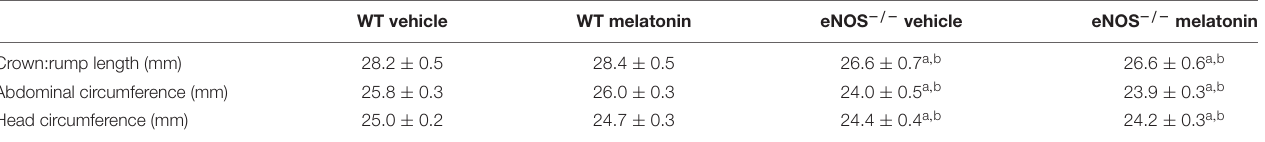
Number of litters as follows; WT vehicle N = 18, WT melatonin N = 20, eNOS − / − vehicle N = 13, eNOS − / − melatonin N = 17. a P < 0.001 compared with WT vehicle, b P < 0.001 compared with WT melatonin, generalized linear mixed models with sequential Sidak post-test.